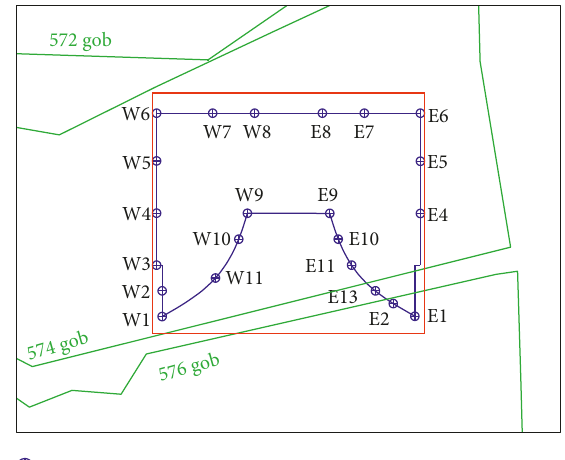
Figure 11: Location of the building and the monitoring